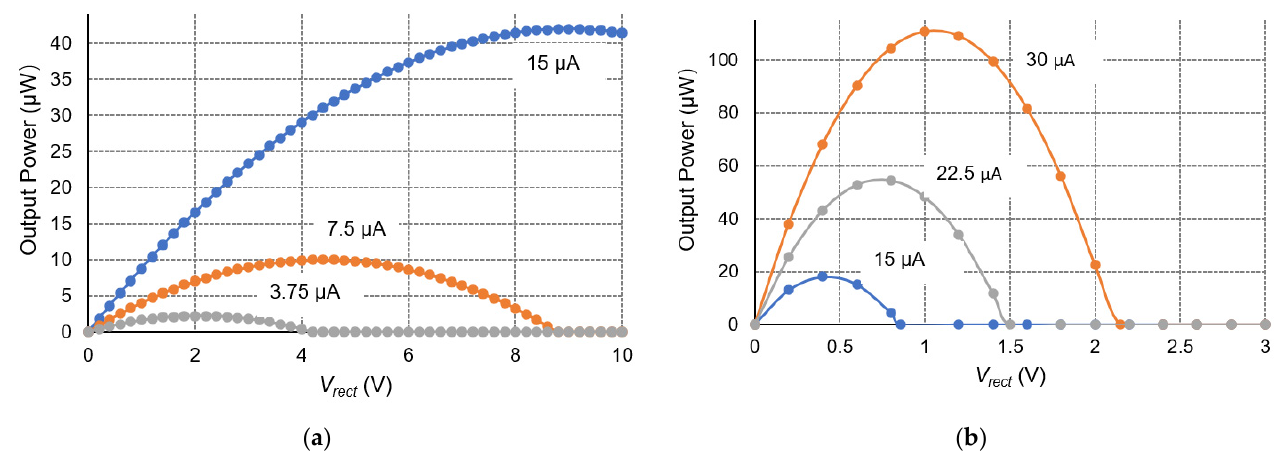
Figure 3. Output power versus V rect for a typical ( a ) P-SSHI circuit and ( b ) S-SSHI circuit.